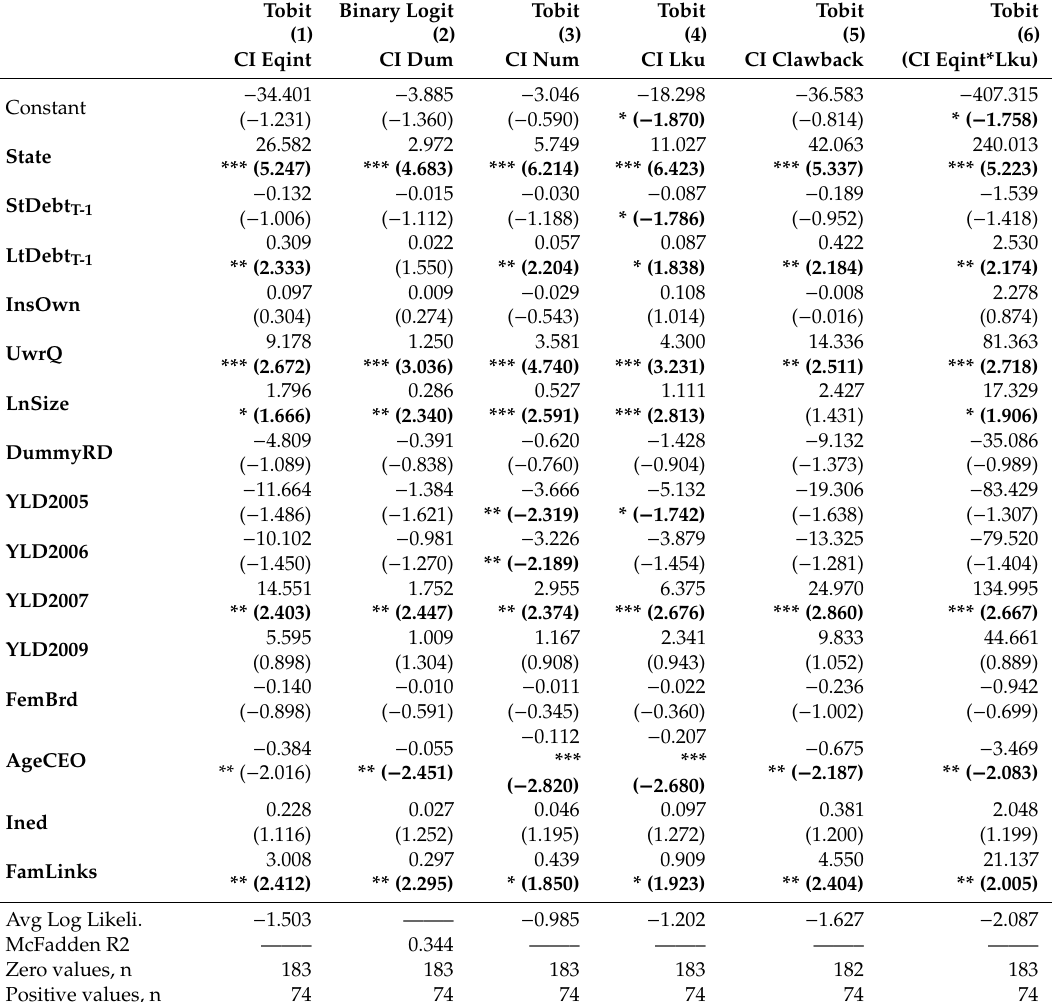
The z statistic (in parentheses) is the lower figure, while the estimated coe ffi cient is the upper one. *, **, *** Denotes significant z-statistics at respective levels of 10, 5 and 1 percent. All standard errors are subject to Huber / White